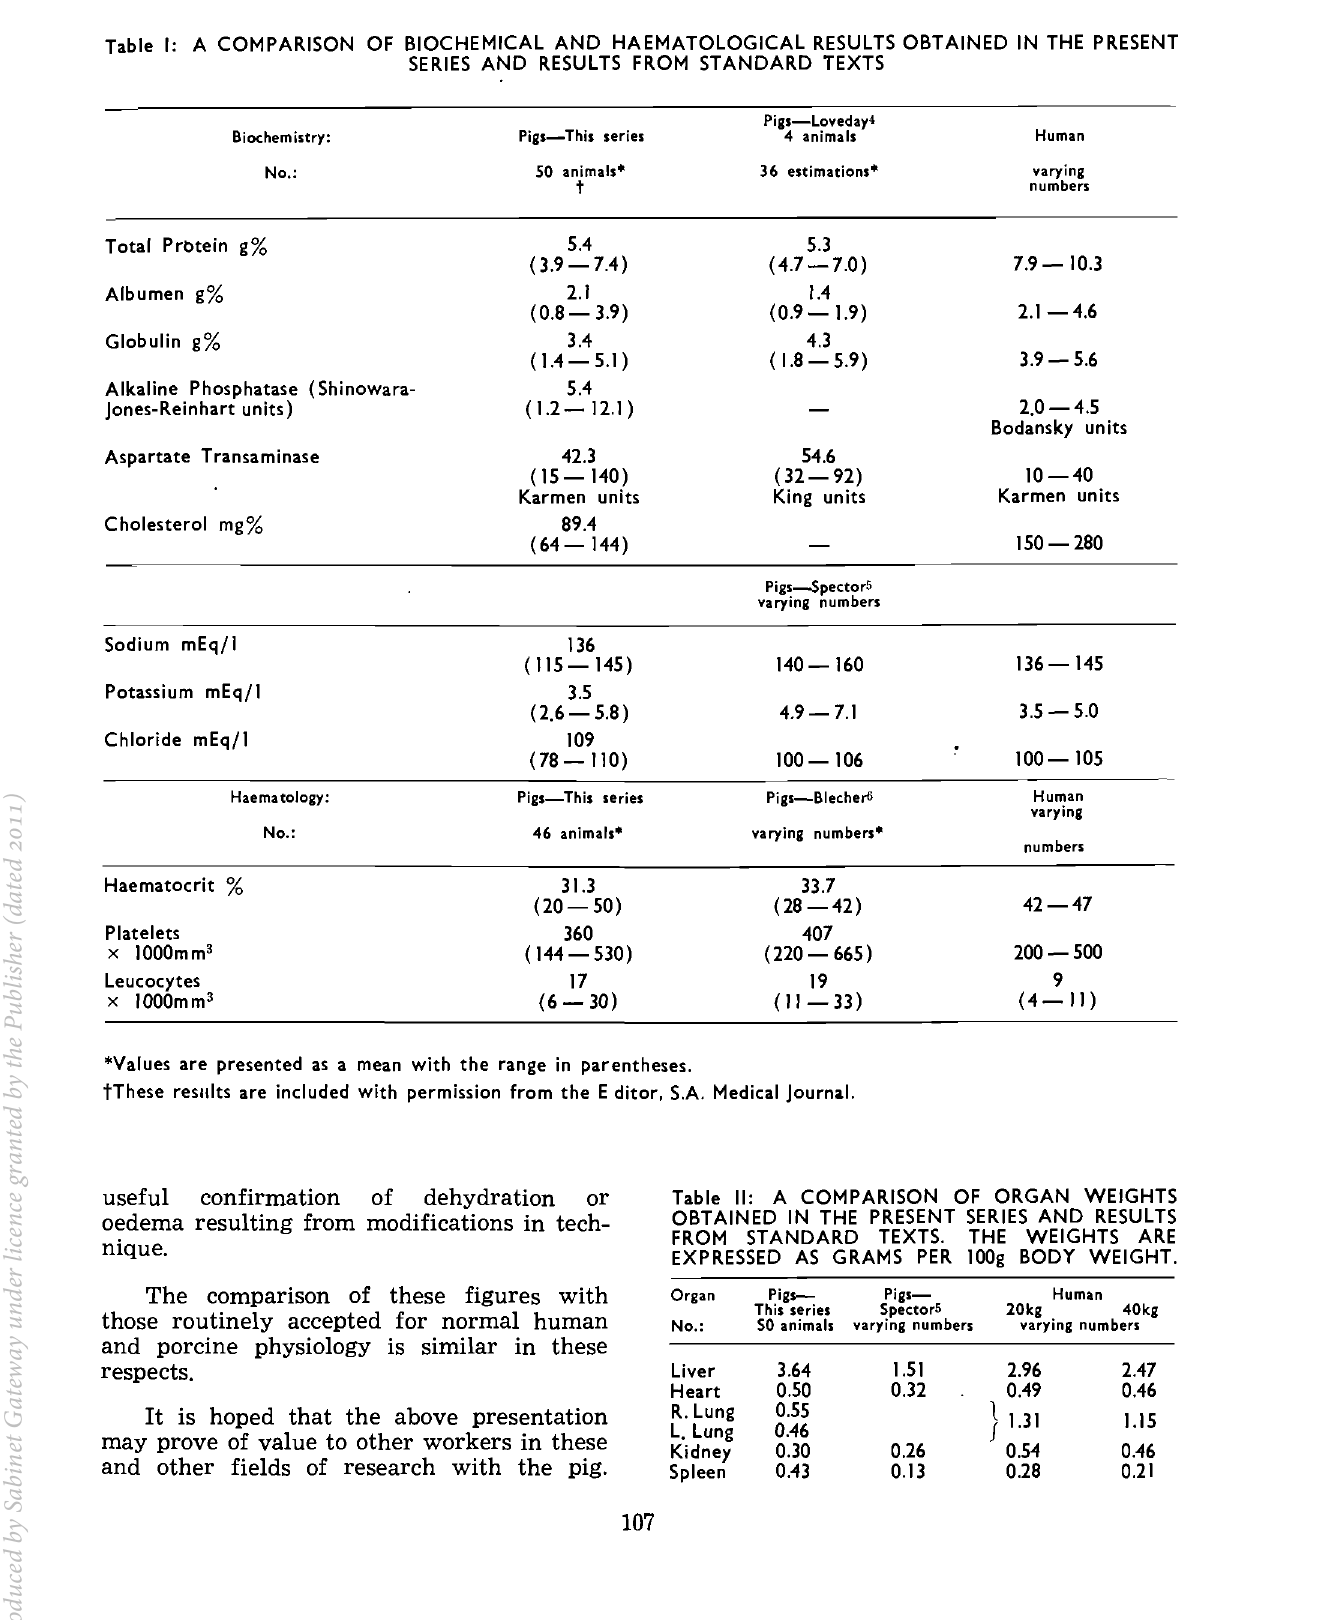
Table I: A COMPARISON OF BIOCHEMICAL AND HAEMATOLOGICAL RESULTS OBTAINED IN THE PRESENT SERIES AND RESULTS FROM STANDARD TEXTS